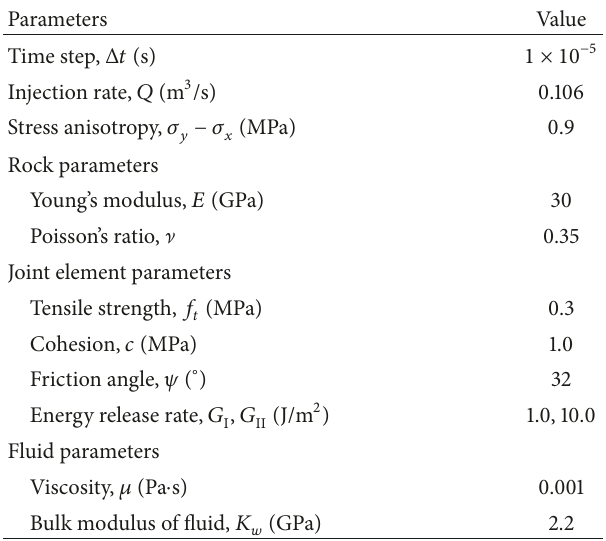
Table 2: Parameters for simultaneous multifracture propagation from a horizontal